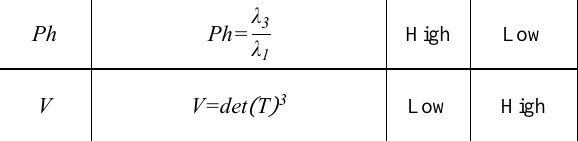
Table 2. Polarimetric features and their expected behavior over sea surface with and without oil slicks.